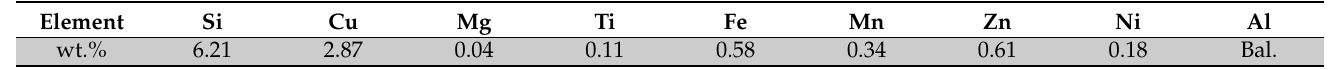
Table 2. Average chemical composition of A319 alloy used in this